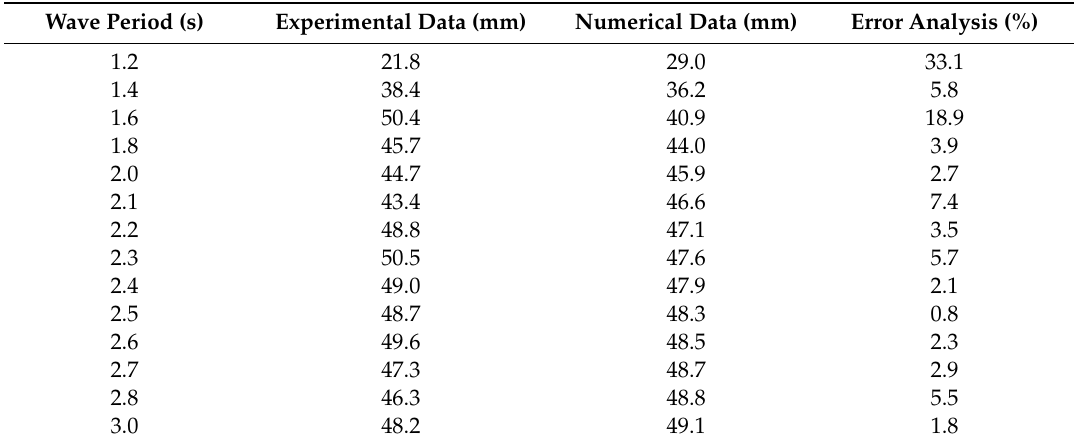
Table 4. Calculation error for oscillatory movement.